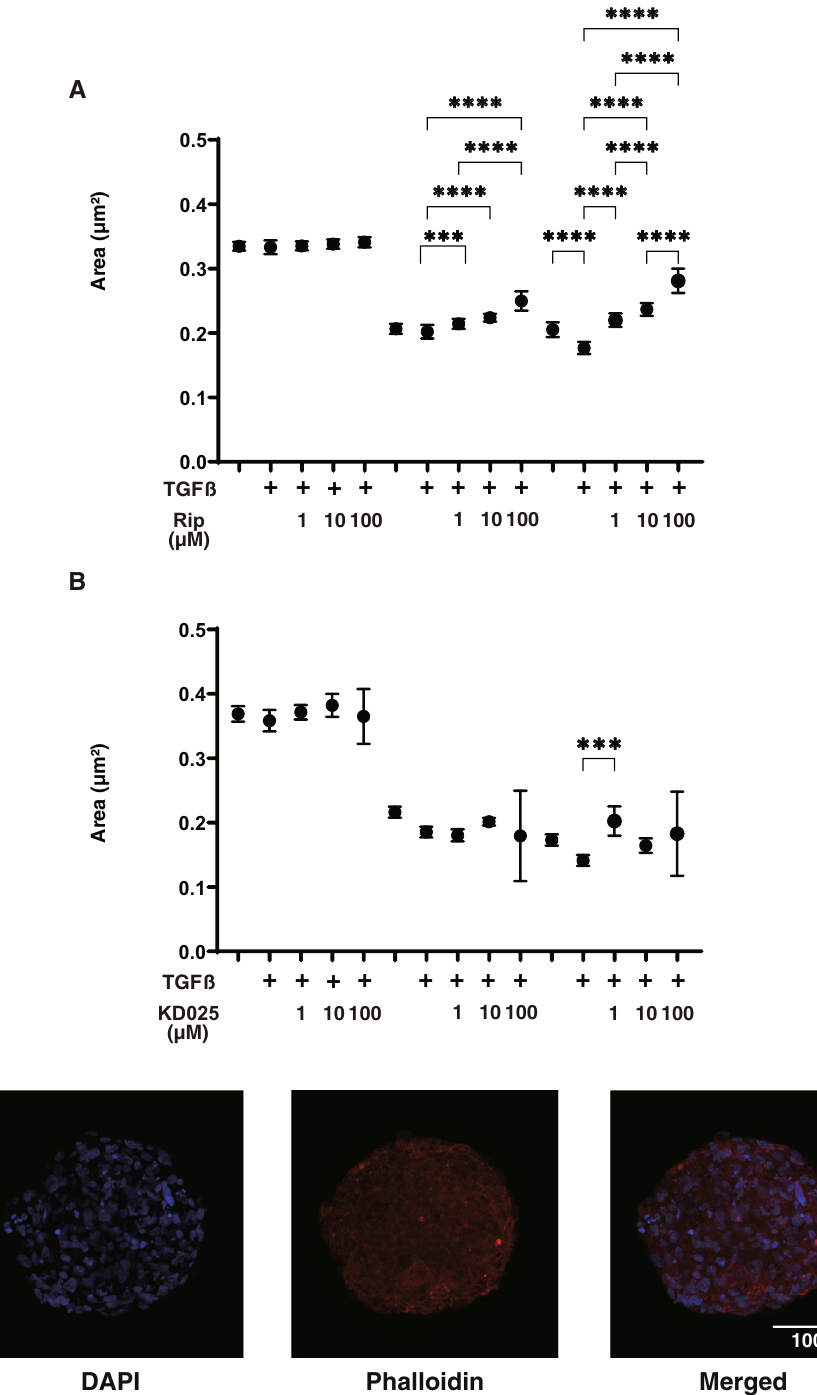
Figure 2. Changes in TGFβ2 treated 3D HTM sphenoid size at Day 1, 3 or 6 in the presence and absence of different concentrations of ripasudil ( A ) or KD025 ( B ), and representative non-treated 3D sphenoid image stained with DAPI and phalloidin ( C ). At Day 1, 3 or 6, the mean sizes of HTM 3D sphenoids (non-treated control) and those treated by 5 ng/ml TGFβ2 were plotted in the absence or presence of 1, 10 or 100 μM ripasudil (Rip, panel A ) or KD025 (panel B ). In panel ( C ), representative immunolabeling image of the non- treated 3D HTM sphenoid at Day 6 stained by DAPI and phalloidin. These experiments were performed in triplicate using fresh preparations (n = 10 and 5 for size measurement and immunolabeling, respectively). Data are presented as the arithmetic mean ± standard error of the mean (SEM). *** P < 0.005, **** P < 0.001 (ANOVA followed by a Tukey’s multiple comparison